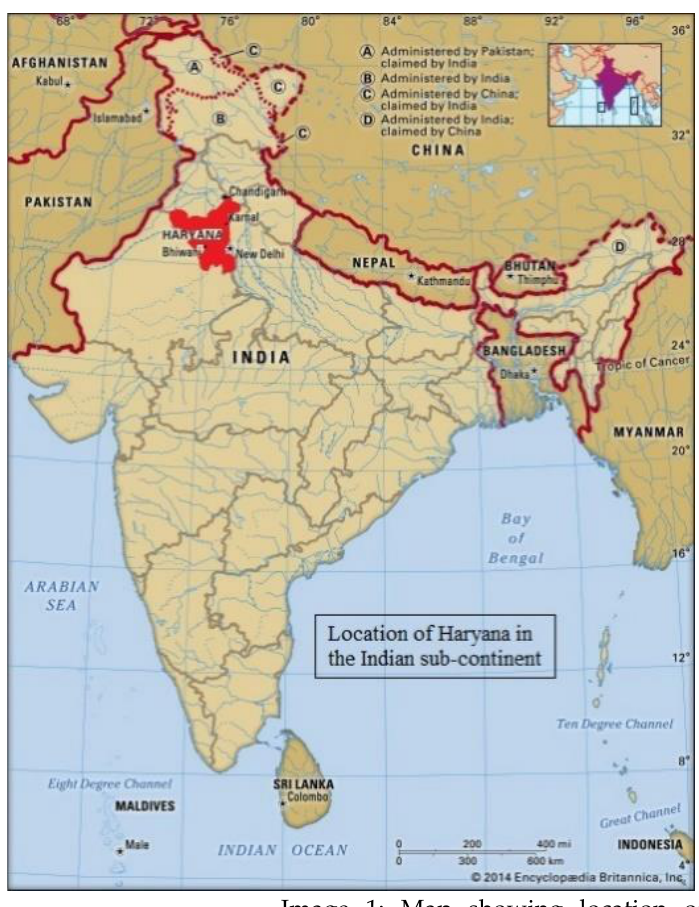
Image 1: Map showing location of study site Haryana (marked in red) in India (Source: